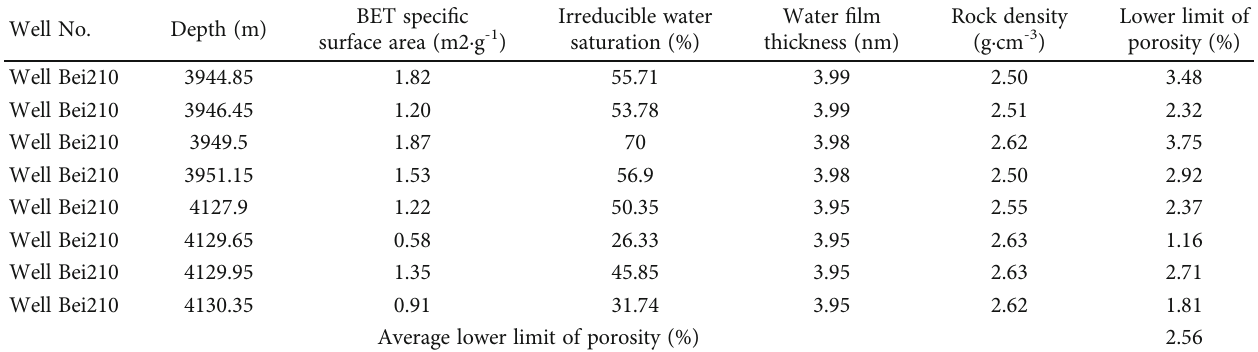
Table 2: Statistics of the lower limit of porosity in the Longfengshan area. Well No.